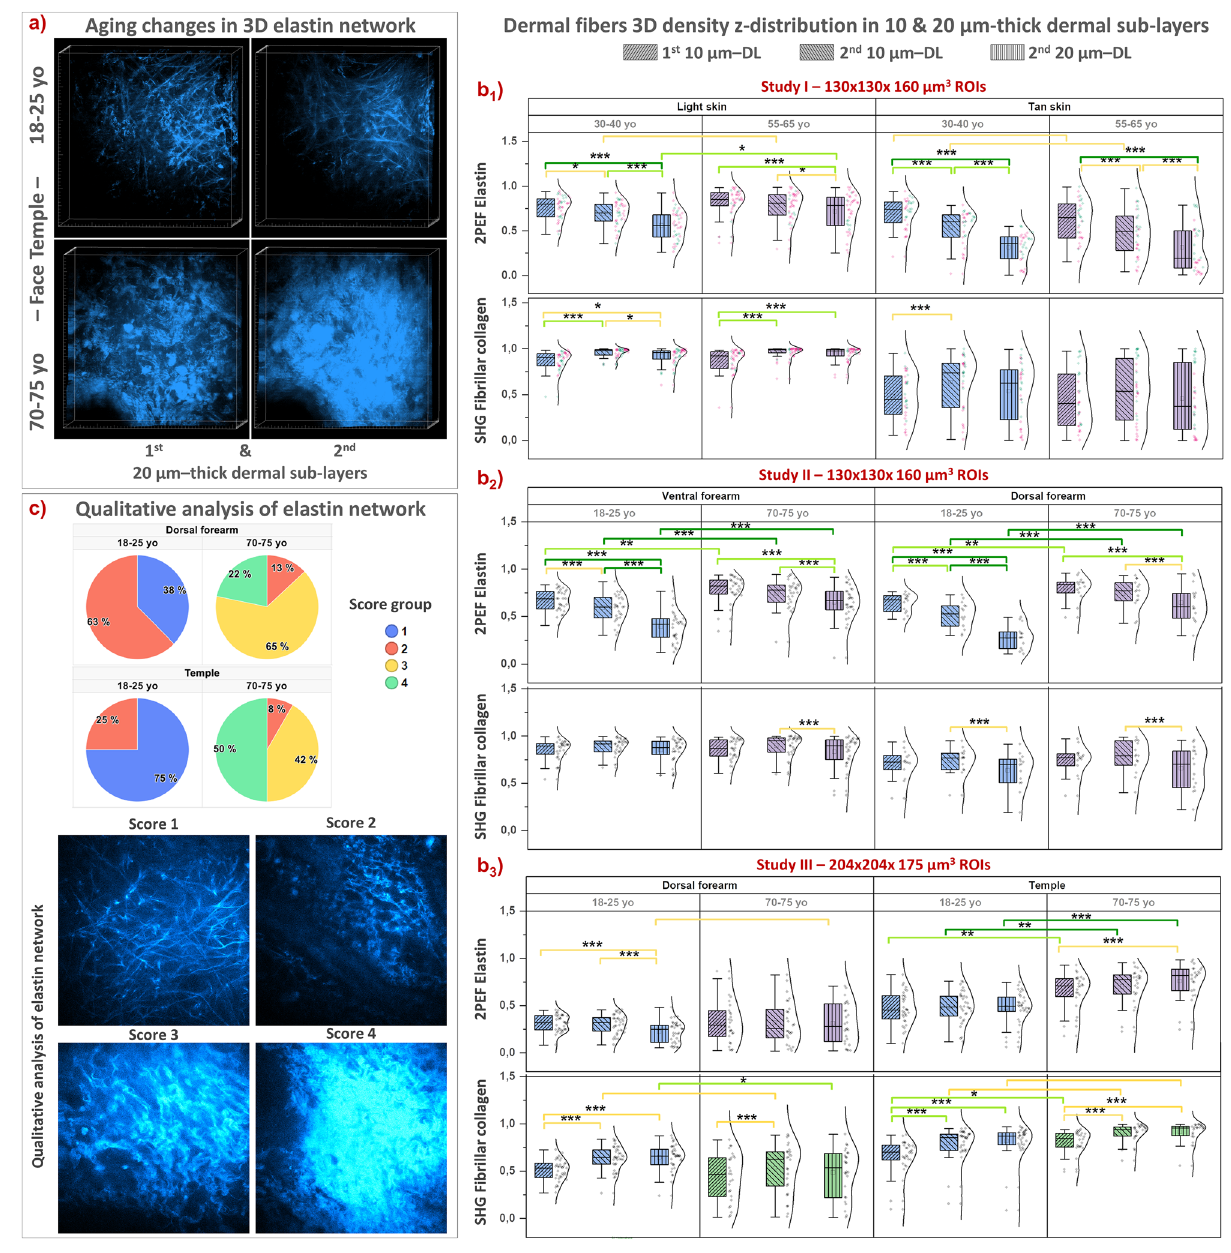
Figure 8. Multiphoton — Aging differences in elastin network organization and in the z-dermal distribution of elastin and collagen fibers 3D density. Data from 3 clinical trials and within the 1st 10 µm, 2nd 10 µm and 2nd 20 µm thickness normalized dermal sublayers (DL) that follow the DEJ shape: study I acquired with DermaInspect on ventral forearm (30–40 vs 55–65 year-old; “light” ITA II vs “tan” ITA IV skin color groups); study II acquired with DermaInspect on ventral and dorsal forearms (18–25 vs 70–75 year-old); study III acquired with MPT flex on dorsal forearm and face temple area (18–25 vs 70-75 year-old). ( a ) 3D reconstructions of elastin network within the 1st and 2nd 20 µm thick DL of young and old face temple areas. ( b1 – b3 ) z-dermal distribution profiles of 3D mean 2PEF elastin density and 3D mean SHG collagen fibers density; ( c ) Qualitative analysis of elastin network organization on dorsal and face temple areas (study III) with (top) elastin scores frequency and (bottom) representative 2PEF elastin intensity images for each score. The data are expressed as box plots with fences, mean and median (—). All ROIs values and their distribution (dots ( ♦ ) and histogram) are shown on the right side of the boxplot. Overlapping values are highlighted in black ( ♦ ). In study I, the pink ♦ and green ♦ data points correspond to respectively women and men volunteers. All the statistical p -values and ES—effect sizes parameters are given in Table S4. Statistically significant p -values: *≤ 0.05; **≤ 0.01, ***≤ 0.001. The colored brackets indicate the ES—effect size (dark green—very strong [1.3– Inf], light green—strong [0.8–1.3] and yellow—moderate [0.5–0.8]). Only p -values associated with moderate to very strong ES are